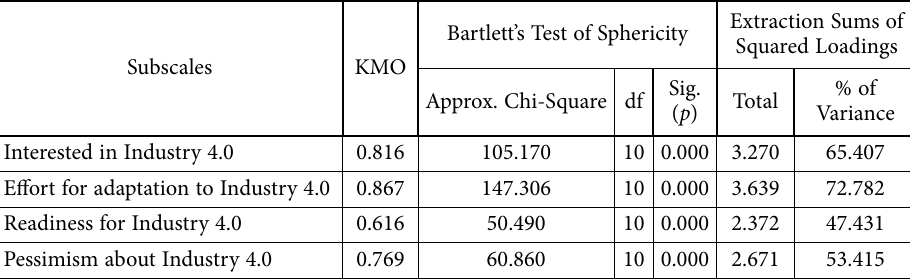
Table 2. Subscales and factor analyses results of the pilot study